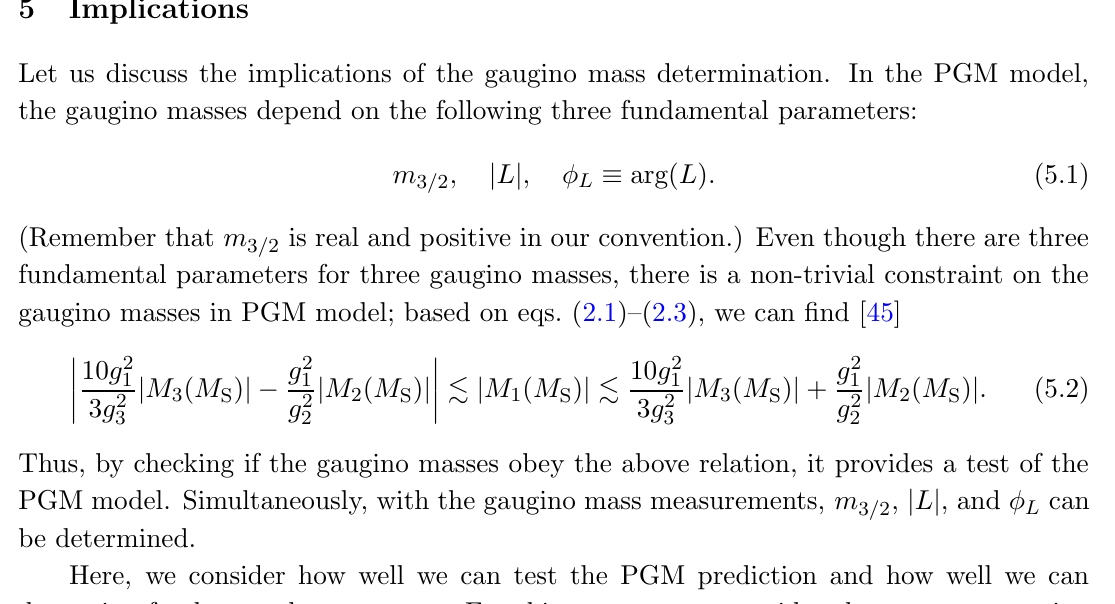
Figure 13 . Contours of constant Bino and Wino masses on the j L j vs. (cid:30) L plane, taking m 250 TeV. The dotted lines show the true Bino and the Wino masses for Sample Point 1, while the bands show expected uncertainties due to the uncertainty in the gaugino mass